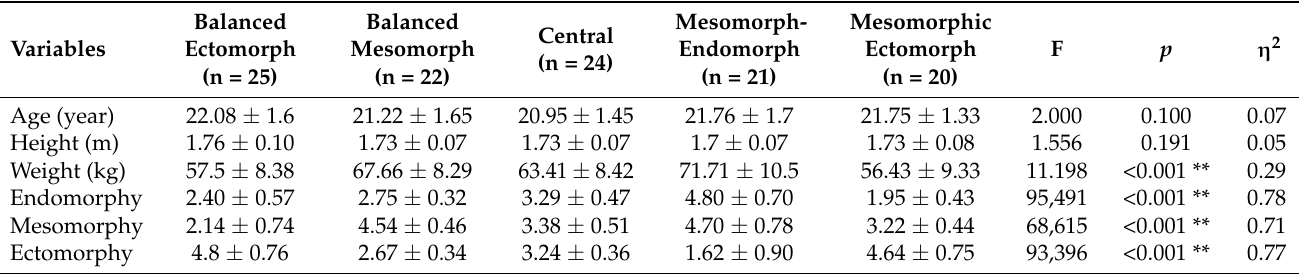
Table 3. Descriptive statistics (mean ± SD) for the demographic variables and somatotype character- istics in participants by dominant somatotype.